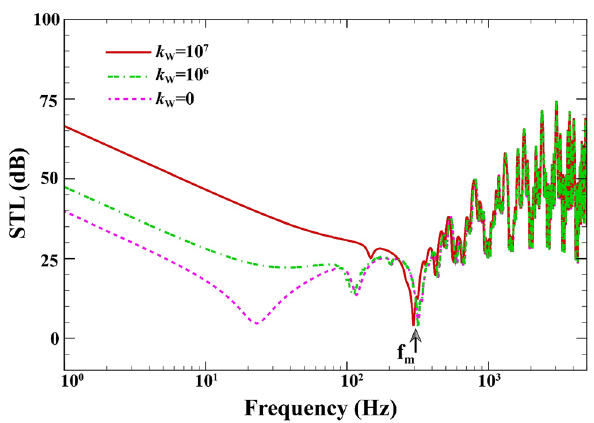
Figure 9. STL of double-walled sandwich composite MEE plate against the viscoelastic medium’s